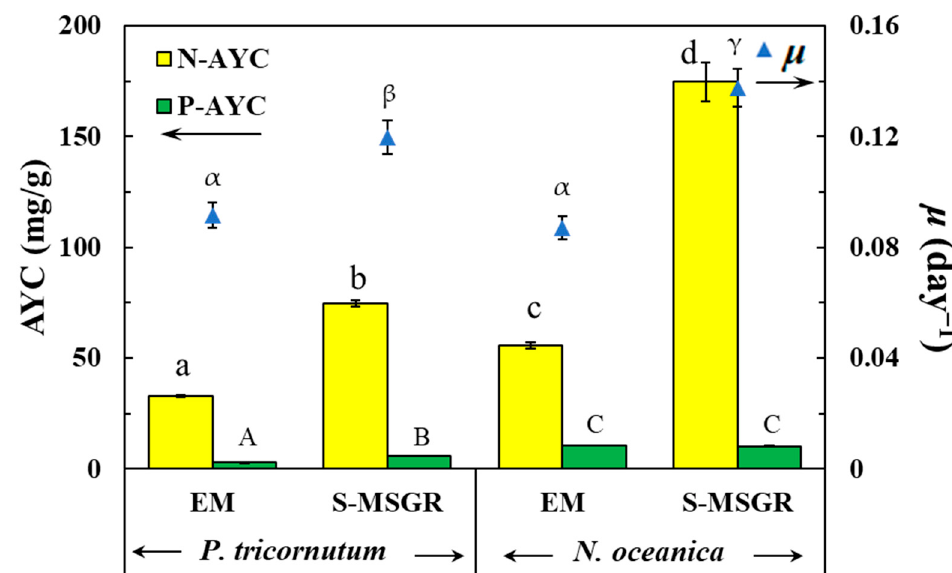
Figure 2. The nutritional assimilation and the average specific growth rate ( µ , day − 1 ) of P. tricornutum and N. oceanica grown in standard medium (EM) and in S-MSGR. Values are expressed as means ± s.d. ( n = 3). Values with the same letter (a, b, c, d; A, B, C or α , β , γ ) show no significant difference of N-AYC, P-AYC or µ between groups, respectively ( p > 0.05, Duncan’s test).